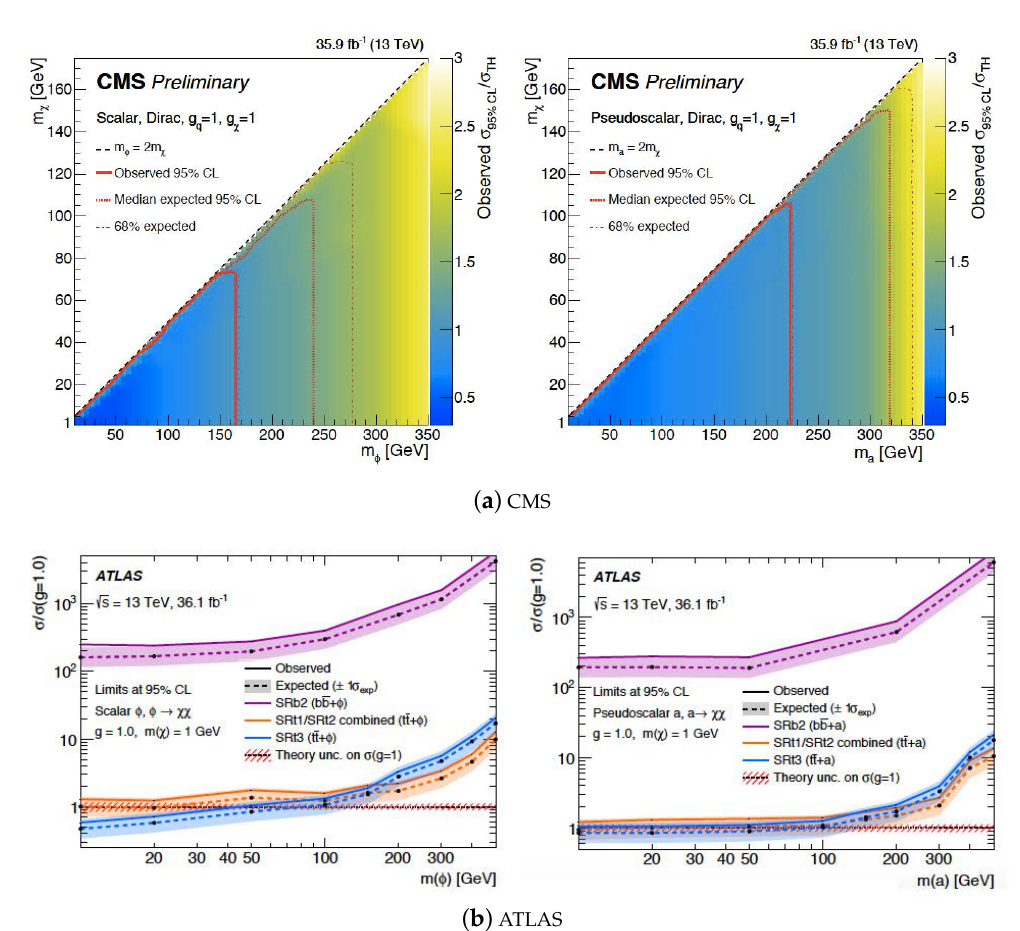
Figure 9. Main results for the t¯t + DM analyses in CMS [19] ( a ) and ATLAS [21] ( b ). On the left, the results for a scalar mediator are shown, and on the right, the results for a pseudoscalar mediator. Both the coupling of the mediator to quarks (g q ) and the coupling to DM (g χ ) are set to one. CMS presented the results of the combination of three t¯t final states as limits on the mediator mass versus DM particle mass. ATLAS fixed the m χ to 1 GeV and showed the limits on the mediator mass, without combining the results of the different final